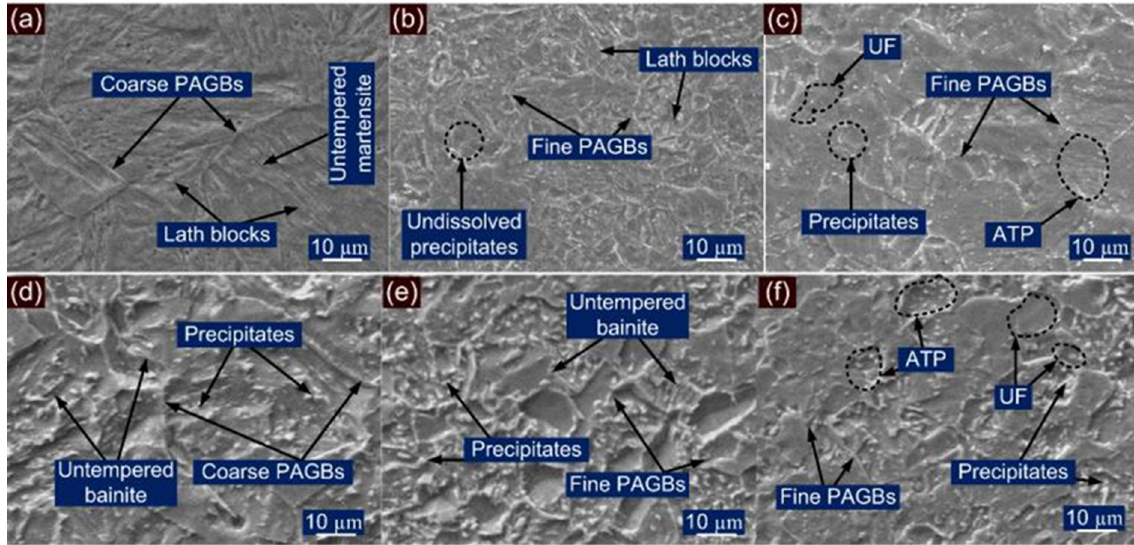
Figure 7. Typical SE image of HAZ region of P91 steel: ( a ) coarse-grained HAZ, ( b ) fine-grained HAZ, ( c ) inter-critical HAZ; HAZ region of P22 steel: ( d ) coarse-grained HAZ, ( e ) fine-grained HAZ, ( f ) inter-critical HAZ.